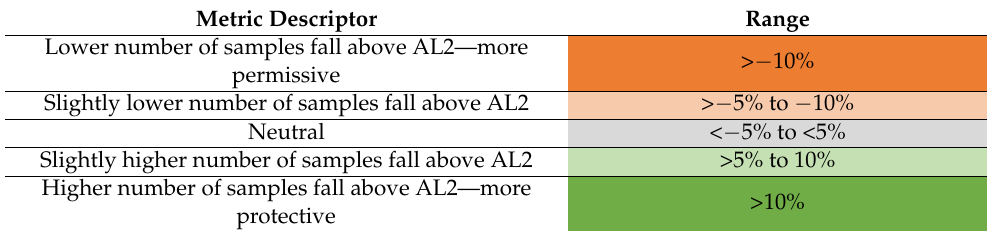
Table 3. Metrics used to interpret scenario comparisons for the current AL2.